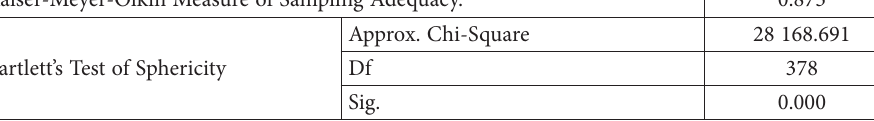
Table 4. KMO and Bartlett’s test Kaiser-Meyer-Olkin Measure of Sampling